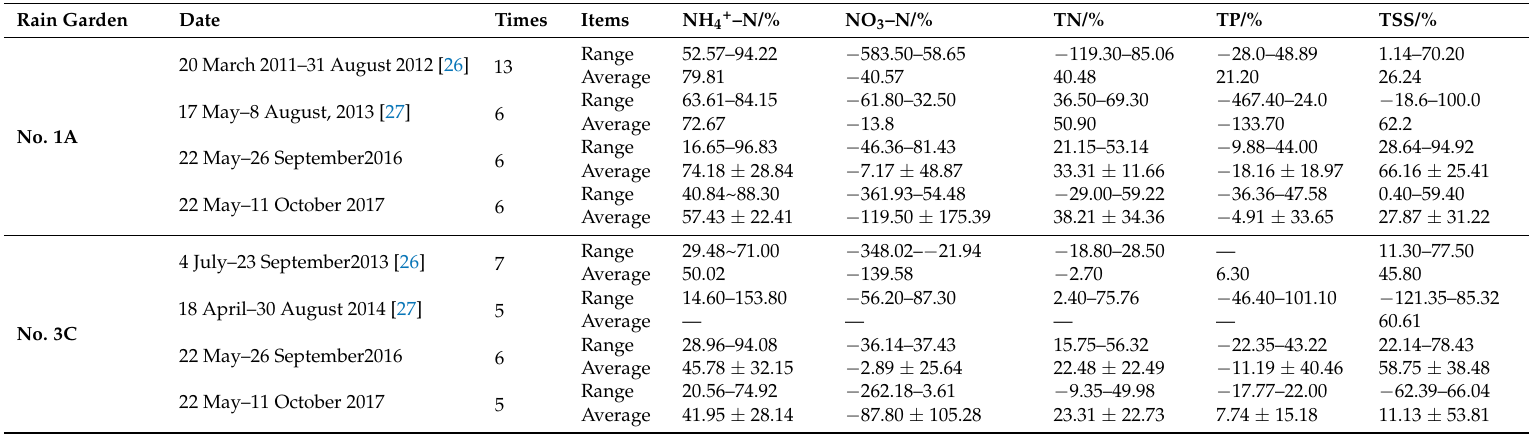
Table 3. Effect of runoff pollutant removal